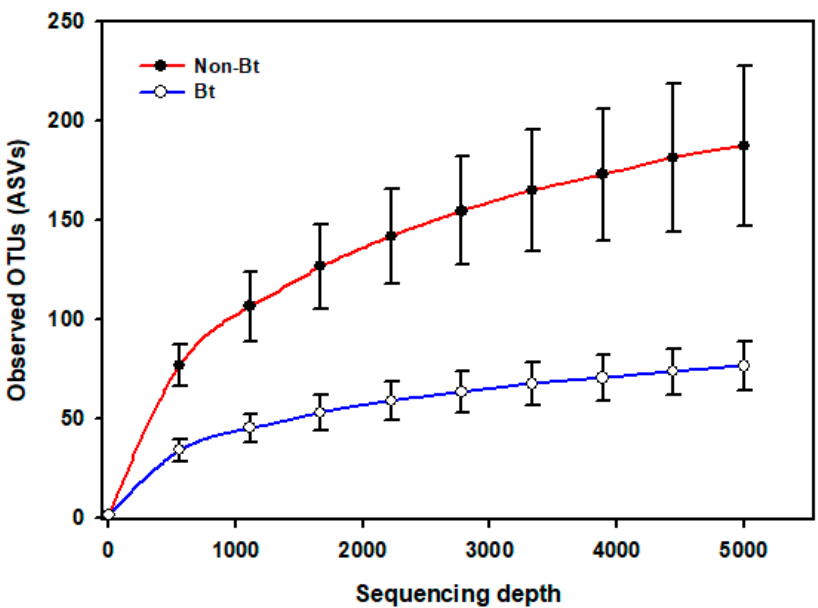
Figure 4. Rarefaction curves of the mean number of observed OTUs (sequence variants) from internal DNA samples of the bollworm, Helicoverpa zea . Samples were third stadium larvae from non-Bt (PHY425RF) and Bt (WideStrike, PHY444WRF, Cry1Ac + Cry1F) cotton in season 2. Sequences were obtained from amplified DNA fragments from V3–V4 hypervariable regions of the 16S rRNA gene.